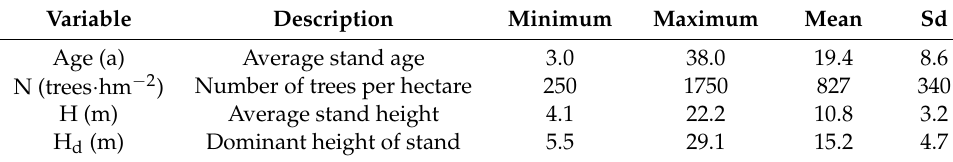
Figure 1. Distribution of sampling plots at the Tropical Forestry Experimental Centre. Table 1. Summary statistics of plot data stand investigation factors.